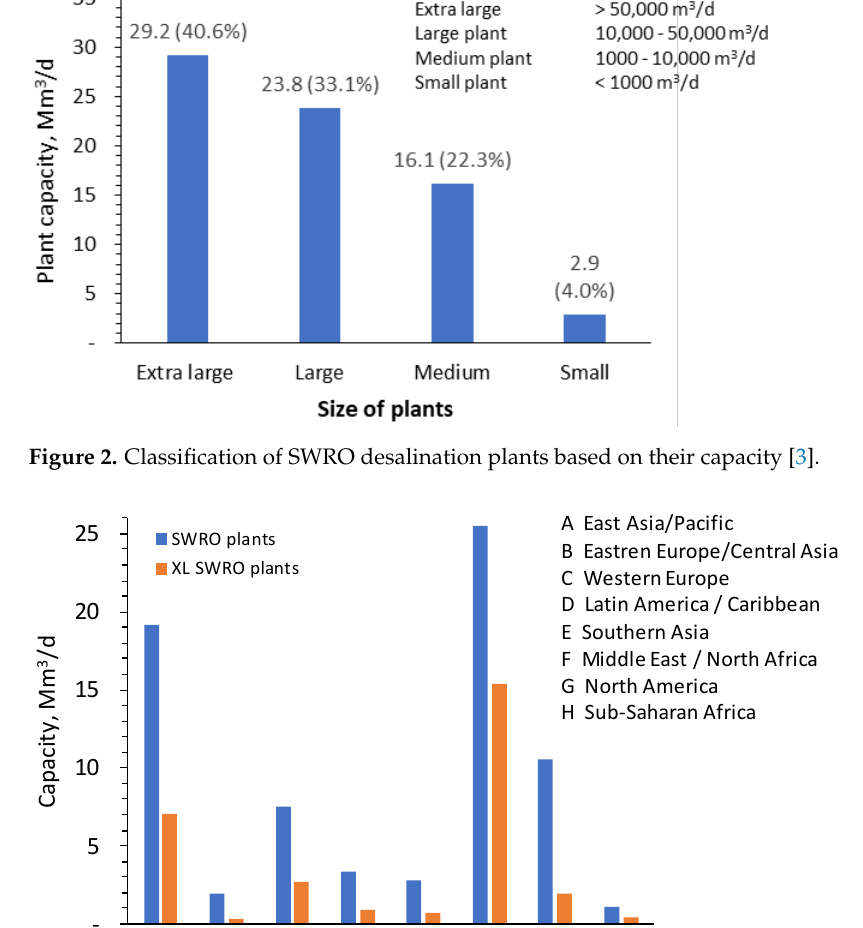
Membranes 2022 , 12 , x FOR PEER REVIEW Figure 3. Total capacity of SWRO and share of extra-large plants in different regions of the world [3]. Figure 3. Total capacity of SWRO and share of extra-large plants in different regions of the world [3]. Figure 3. Total capacity of SWRO and share of extra-large plants in different regions of the world [3].